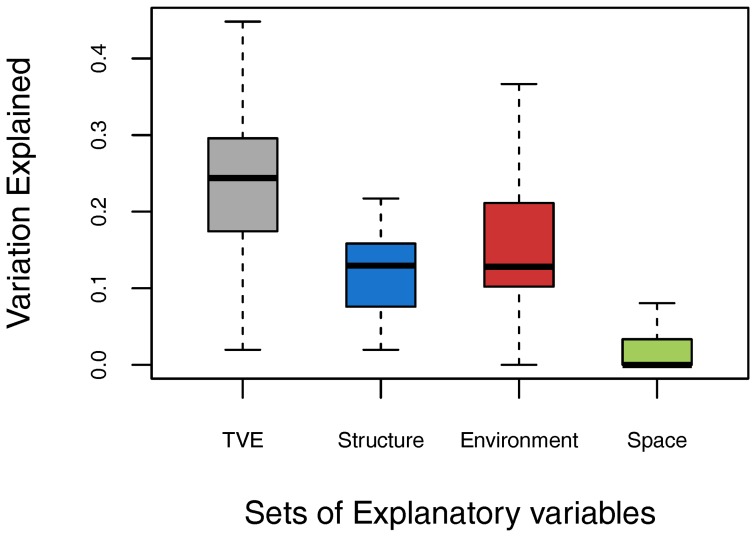
Variation Explained across stands.Boxplot showing the variability in how well ground layer species turnover was explained by multiple regression on distance matrices models (MRMs) in 11 old-growth beech stands in southern Europe. The first three boxplots correspond to models where explanatory variables are based on forest structural distances only, abiotic environmental distances only and spatial distances only. The last boxplot reports on the total variation explained (TVE) by the full models that include the explanatory variables of all three categories.